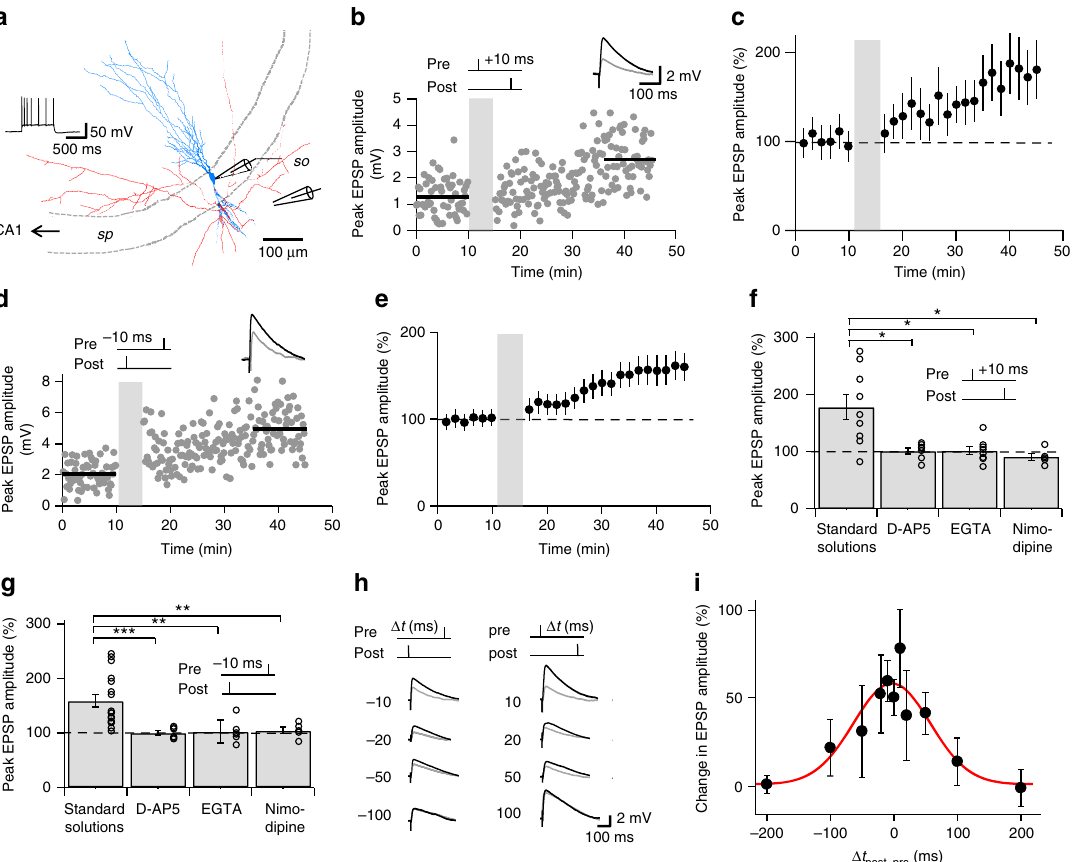
Figure 1 | Noncanonical STDP induction rules at CA3–CA3 recurrent synapses. ( a ) Neurolucida reconstruction of a representative CA3 pyramidal neuron filled with biocytin. Inset shows AP phenotype (1-s current pulse, 630pA); recording and stimulation pipettes are indicated schematically. Blue, soma and dendrites; red, axon; sp, stratum pyramidale ; so, stratum oriens . ( b , c ) Pre–postsynaptic pairing induces LTP at CA3–CA3 recurrent synapses. Plot of compound EPSP peak amplitude against experimental time before and after pre–postsynaptic pairing ( D t ¼ þ 10ms; vertical grey bars). Single-cell data ( b ) and mean data ( c ; 9 cells). ( d , e ) Post–presynaptic pairing also induces LTP. Similar plot as in b , c , but for post–presynaptic pairing (with D t ¼ –10ms). Single-cell data ( d ) and mean data ( e ; 17 cells). Insets in b and d show the average of 60 evoked EPSPs before (black) and 20–30min after induction (grey). Scale bar in b also applies in d . In c and e , EPSP amplitude was normalized to the control value before LTP induction (dashed line). ( f , g ) Multiple Ca 2 þ sources were necessary for STDP induction. Summary bar graph shows the effects of 20 m M of the NMDA receptor antagonist D-AP5 (extracellular; 7 and 6 cells), 20mM of the Ca 2 þ chelator EGTA (intracellular; 8 and 6 cells) and 10 m M of the L-type Ca 2 þ channel blocker nimodipine (extracellular; 5 and 5 cells, respectively) on pairing-induced LTP for pre–postsynaptic ( f ) and post–presynaptic sequences ( g ). Circles represent data from individual cells, bars indicate mean ± s.e.m. LTP with both pairing paradigms was largely abolished by all manipulations. ( h , i ) A broad and symmetric STDP curve at CA3–CA3 synapses. Magnitude of potentiation induced by pre–postsynaptic and post–presynaptic pairing was plotted against pairing time interval D t . Representative average traces are shown in h (grey, before induction; black, 20–30min after induction), plot of LTP magnitude (expressed as % increase over baseline) against D t is shown in i (69 cells total). Red curve, Gaussian function without offset fit to the data points. *, P o 0.05; **, P o 0.01; ***, P o